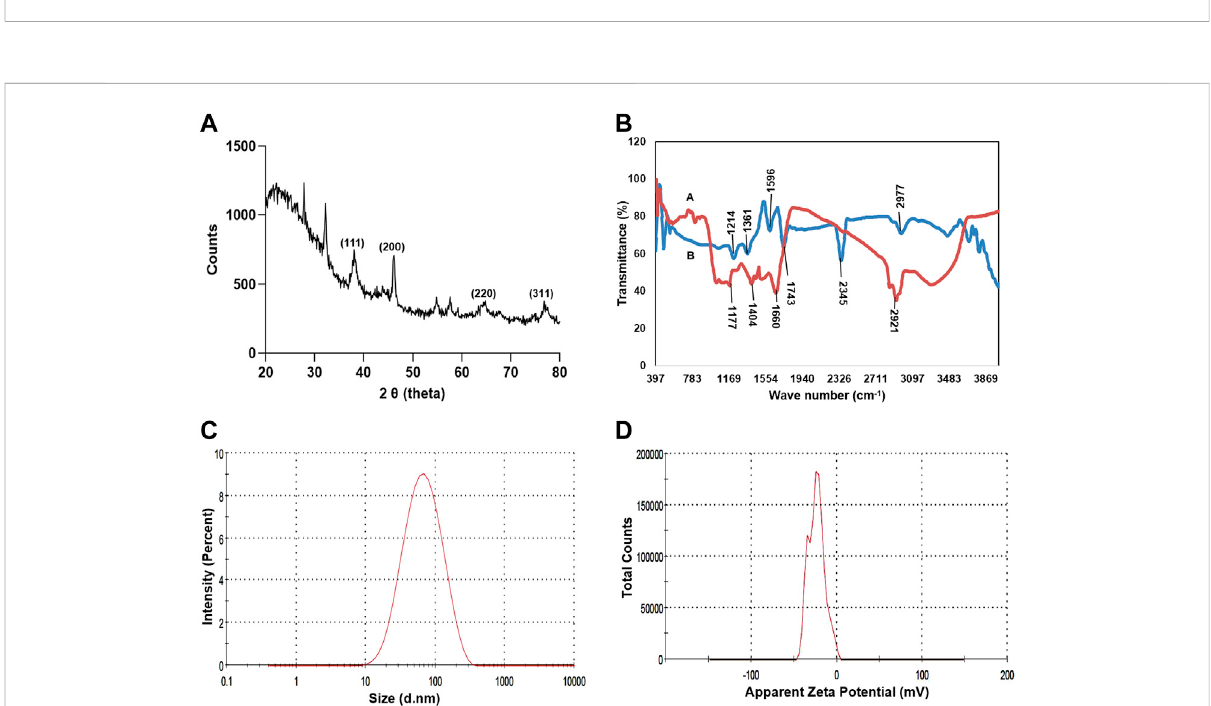
letters on the bars indicate that mean values of treatments are signi fi cantly different at p < 0.01 or p < 0.05 (indicated